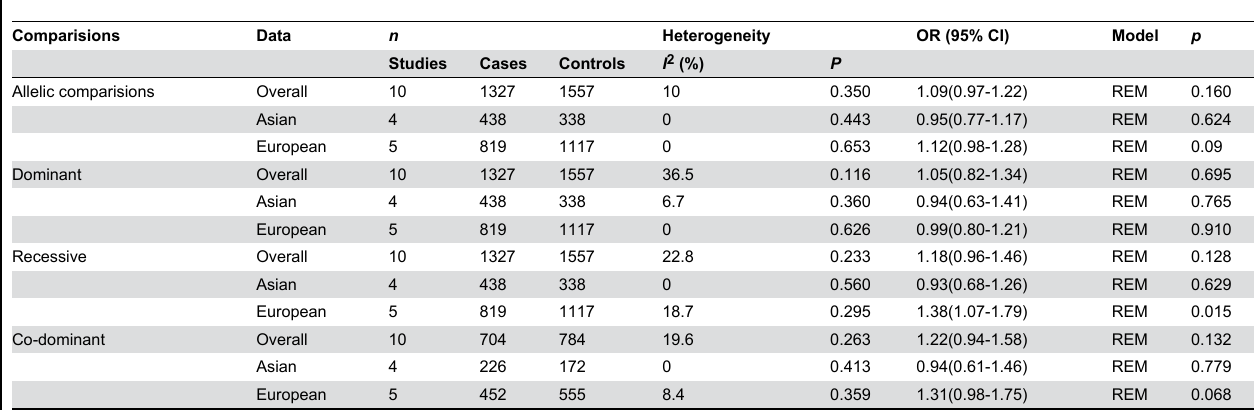
Table 4. Pooled measures for the association between the PAI-1 -675 4G/5G polymorphism and susceptibility to diabetic